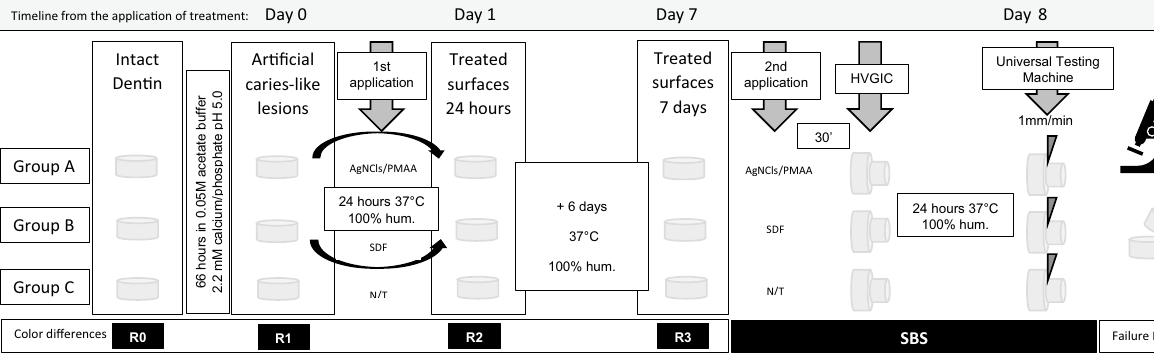
Color changes. Table 1 shows the color differences of each treatment group between each of the consecutive readings. R0 was performed on intact dentin whereas R1 measured color coordinates of demineralized dentin. As this study aimed to compare the effect on color stability of two treatment options applied on demineralized